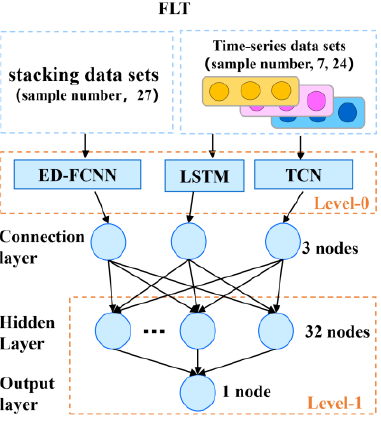
Figure 2. Architectures of the ensemble neural network model (FLT) constructed in this study.